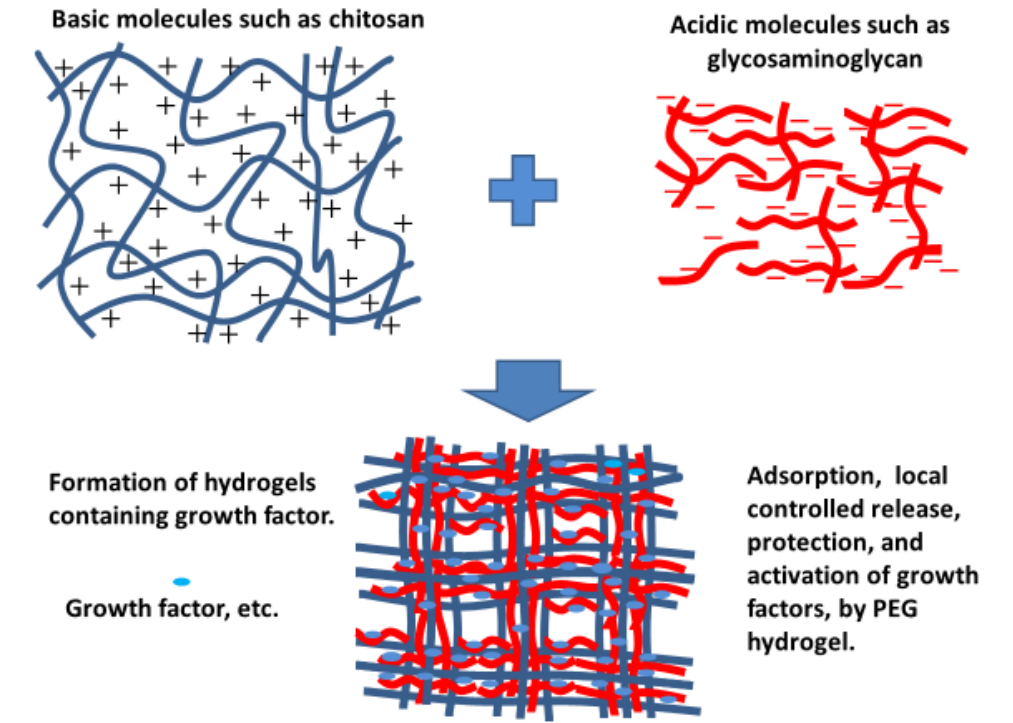
Figure 3. Polyelectrolyte complexes (PECs) comprising acidic and basic polymers.